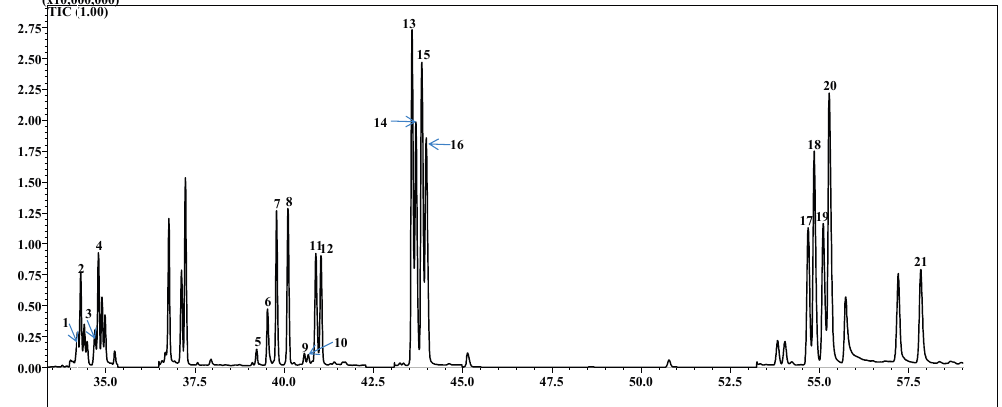
Figure 1. Separation of chiral monoterpenes and deuterium isotopes mixture using MDGC-MS. Numbers referred to the compounds: (1) d 3 -(S)-( − )-limonene, (2) (S)-( −